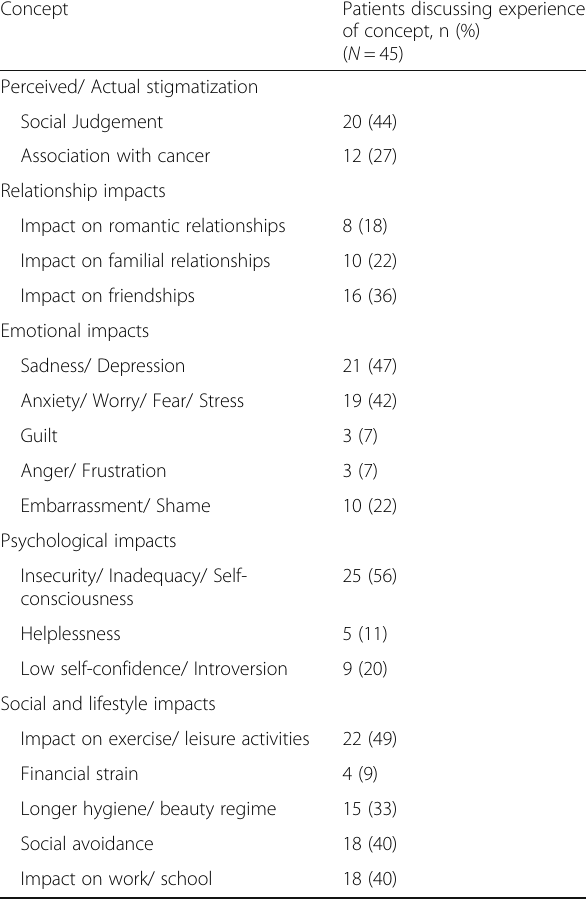
Table 4 Number of patients discussing their experience with each psychosocial concept included in the conceptual model